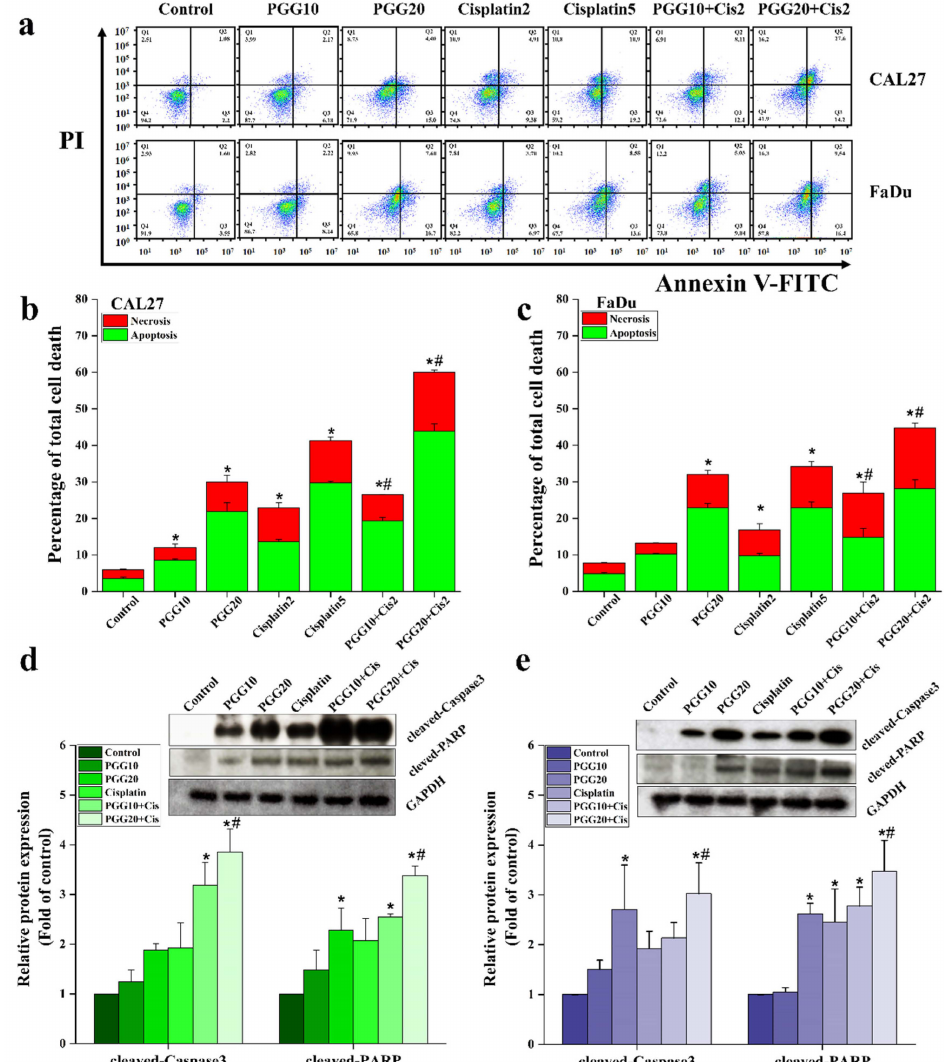
Figure 3. Effect of PGG and cisplatin monotherapy or in combination therapy on apoptosis of HNSCC cancer cells. ( a ) Representative dot plots represent apoptosis responses to therapy with the indicated compound(s) for CAL27 cells and FaDu cells. The quantification data represent the percentage of total cell death in ( b ) CAL27 and ( c ) FaDu cells determined by flow cytometry. Western blot analysis of apoptosis marker, caspase-3, and PARP, the relative density values of related proteins were quantified, and their protein levels were normalized to the loading control GAPDH for ( d ) CAL27 and ( e ) FaDu cells (uncropped images are provided in the Supplementary Figures S4 and S5). All data are expressed as (mean ± SD) of three independent experiments. * p < 0.05: significantly different from control, and # p < 0.05: significantly different from PGG and cisplatin treatment alone. PGG, pentagalloyl glucose; Cis, cisplatin; PARP, poly ADP ribose